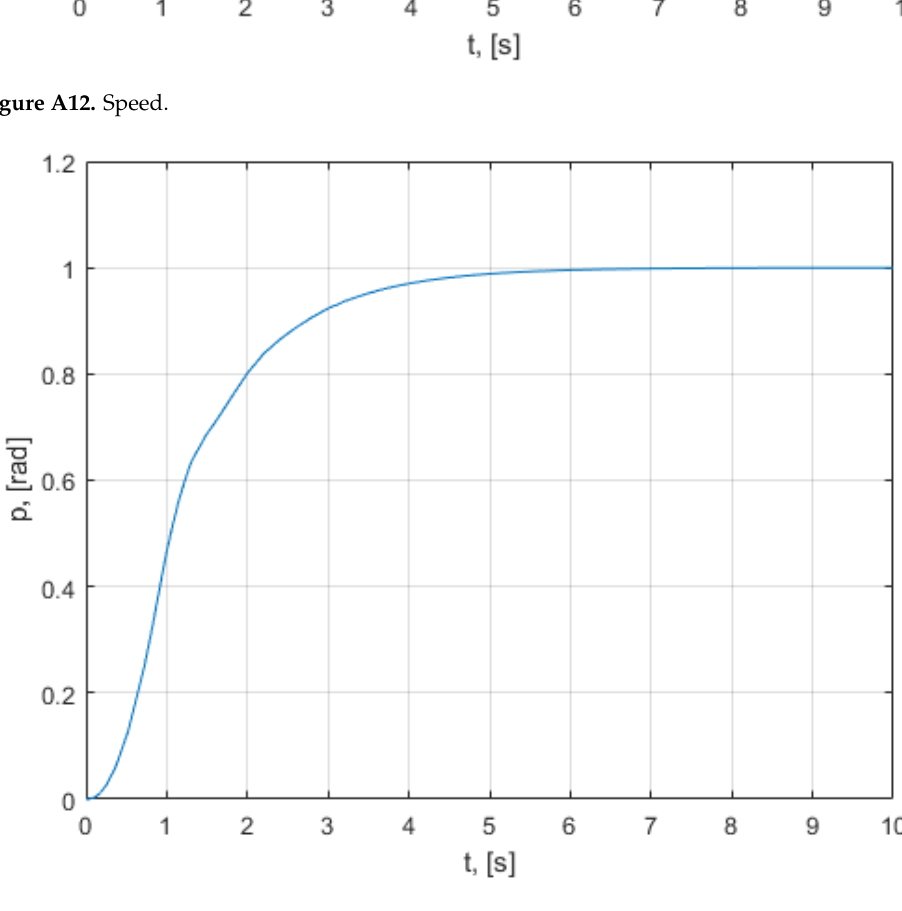
Figure A13. Position. In the steady state, the state feedback control system assures a zero position error. The state feedback control system assures a limited torque at the start, for positive and negative values, and zero torque in the steady state. The state feedback control system assures a limited speed at the start and a zero speed in the steady state. The state feedback control system assures a short response time for position, a zero error in the steady state, a zero overshoot, and asymptotic aperiodic behavior in the transient state. It can be seen that the torque and speed are limited. The response time is shorter than in the case of the error control system.